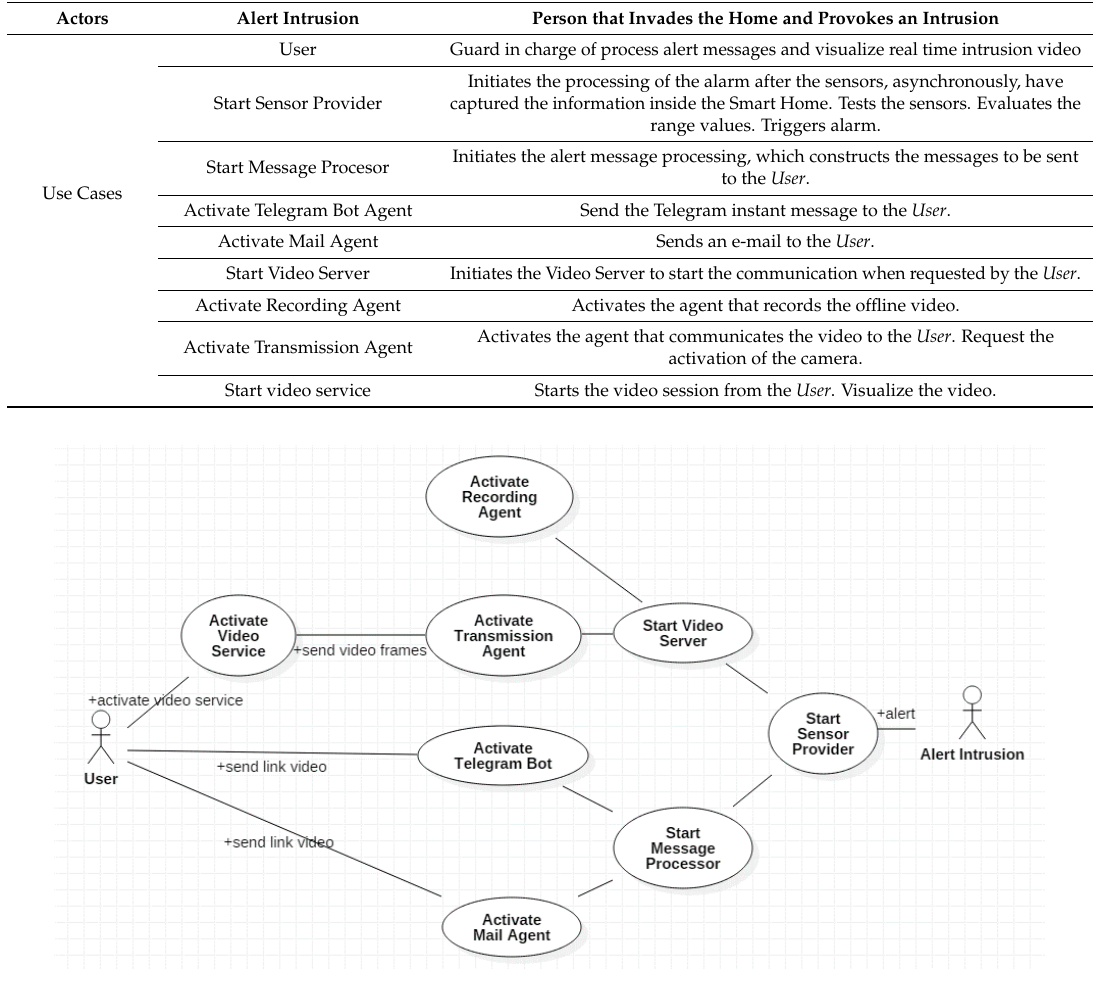
Figure 2. Diagram of actors and use cases of the video surveillance system.